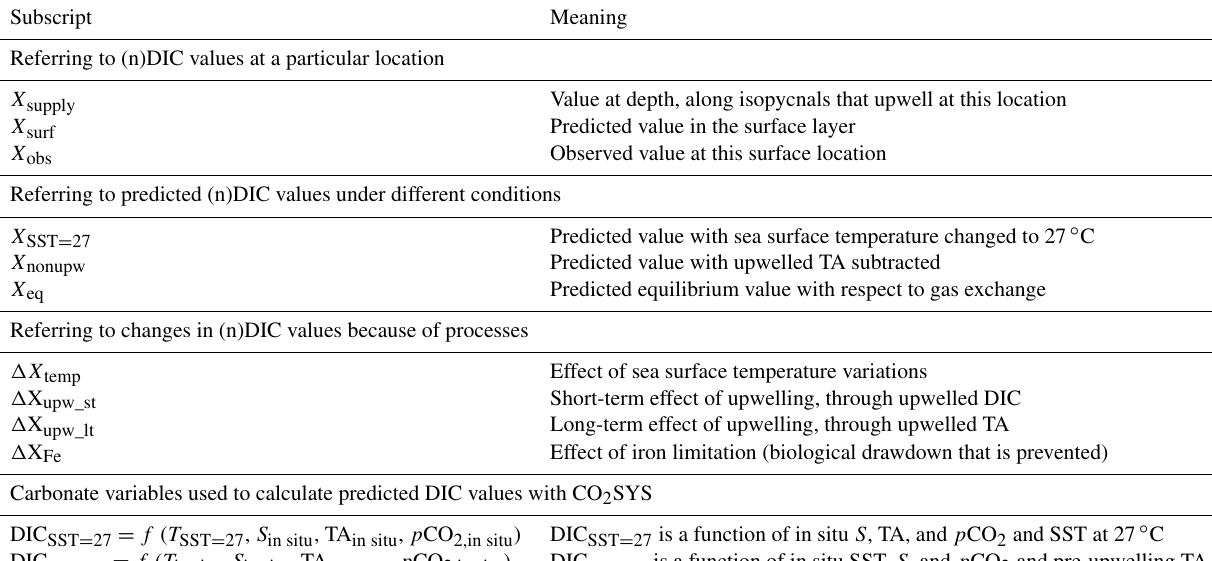
Table 1. Definitions of subscripts and main terms used in the text. X represents any variable involved in the calculations. The program CO 2 SYS was used to calculate values under different